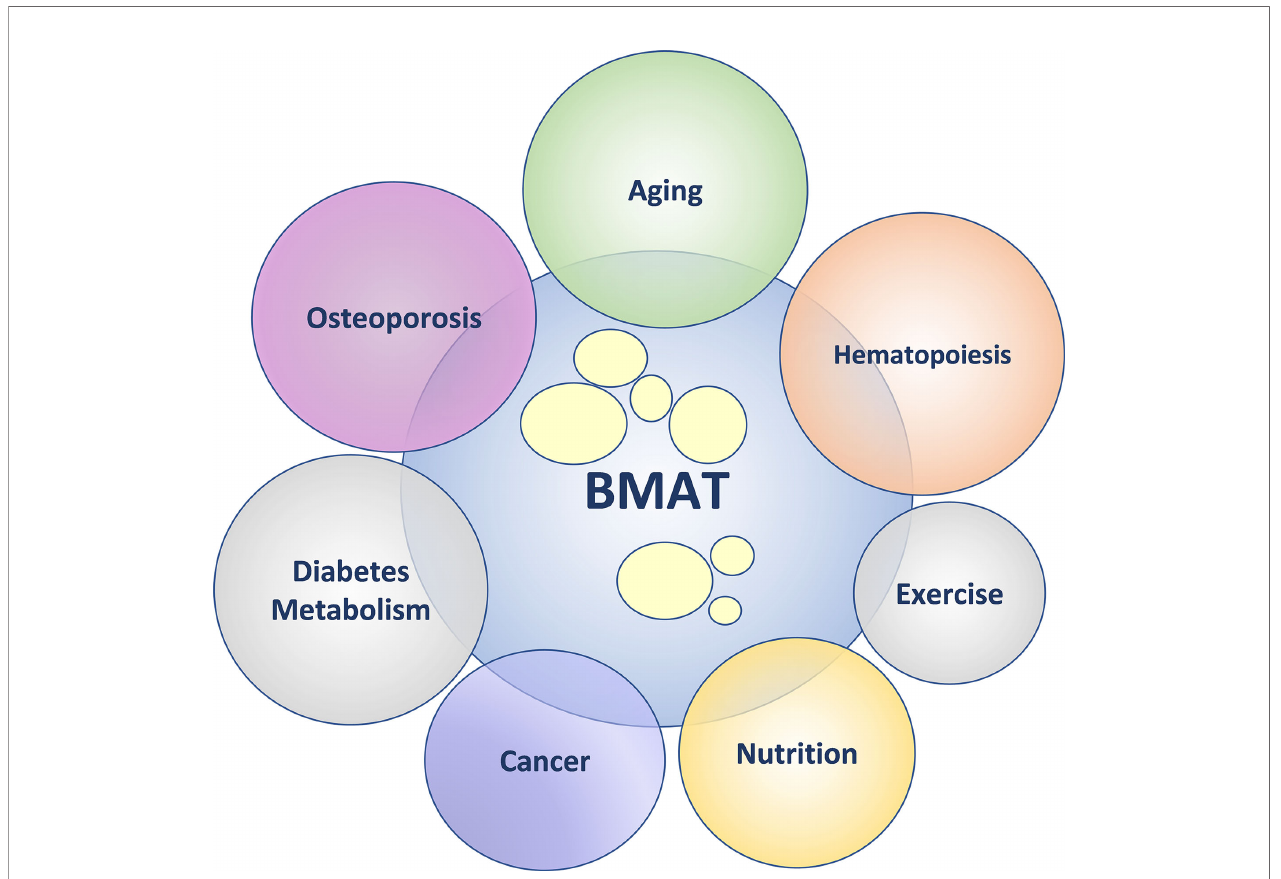
FIGURE 1 | Bone marrow adipose tissue (BMAT) – friend or foe? In health, BMAT supports physiological homeostasis. In pathological states, BMAT augments dysregulation of physiological homeostasis. The diagram depicts the emerging topics within the fi eld of BMAT